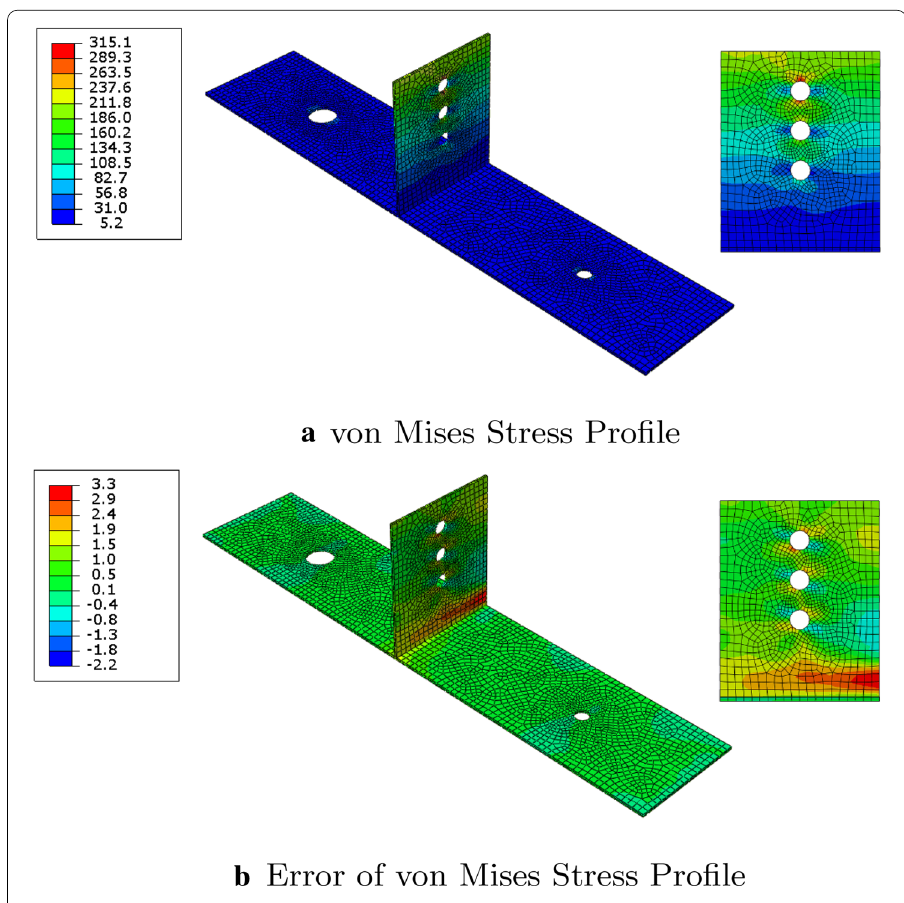
Fig. 12 Triple webbing holes feature model results in